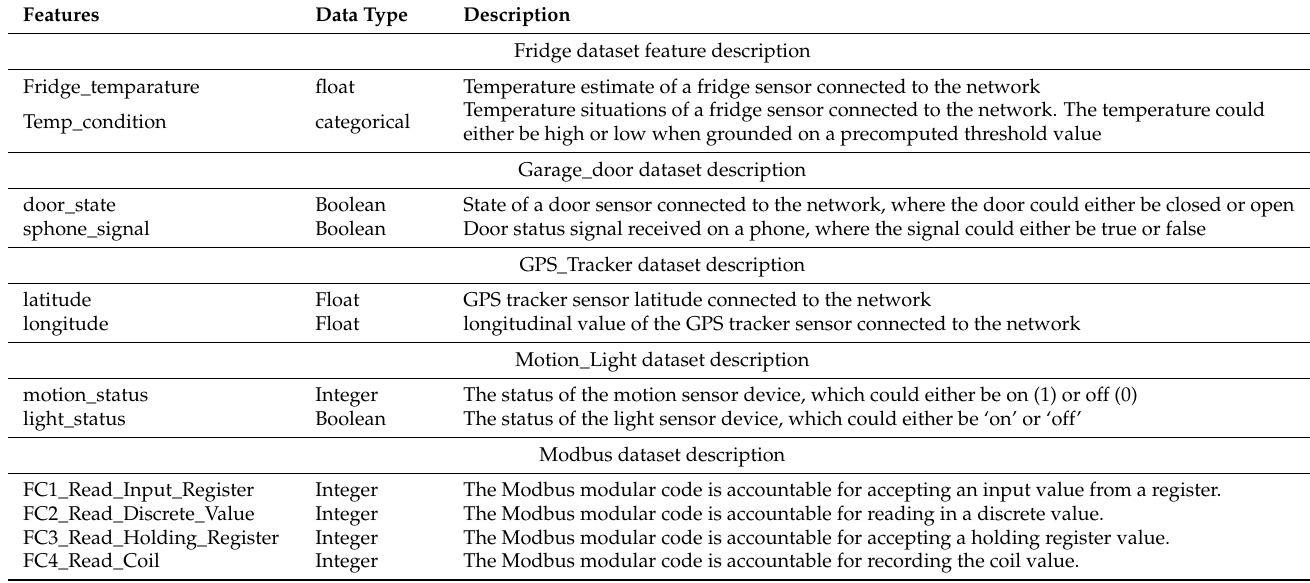
Table 1. The IoT Telemetry dataset feature